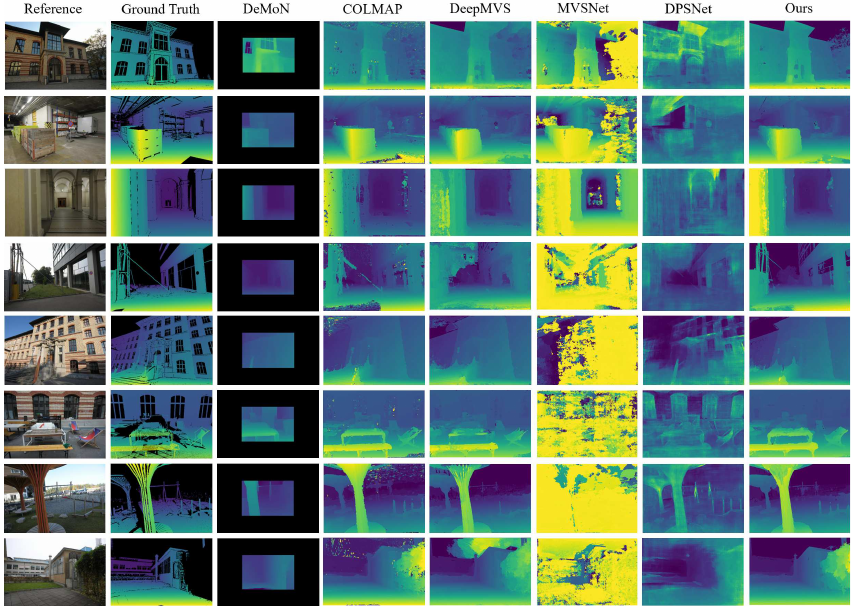
Figure 5. Qualitative comparison of different algorithms on the ETH3D